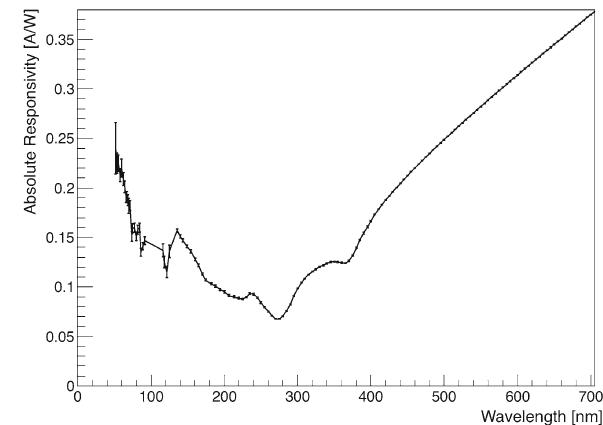
Fig. 5 The AXUV100G photodiode [29] absolute responsivity cali- bration as a function of wavelength from NIST in the range of 50– 700nm.Thephotodiode wascalibratedinFebruary2016[32]forwave- lengths 50–1100